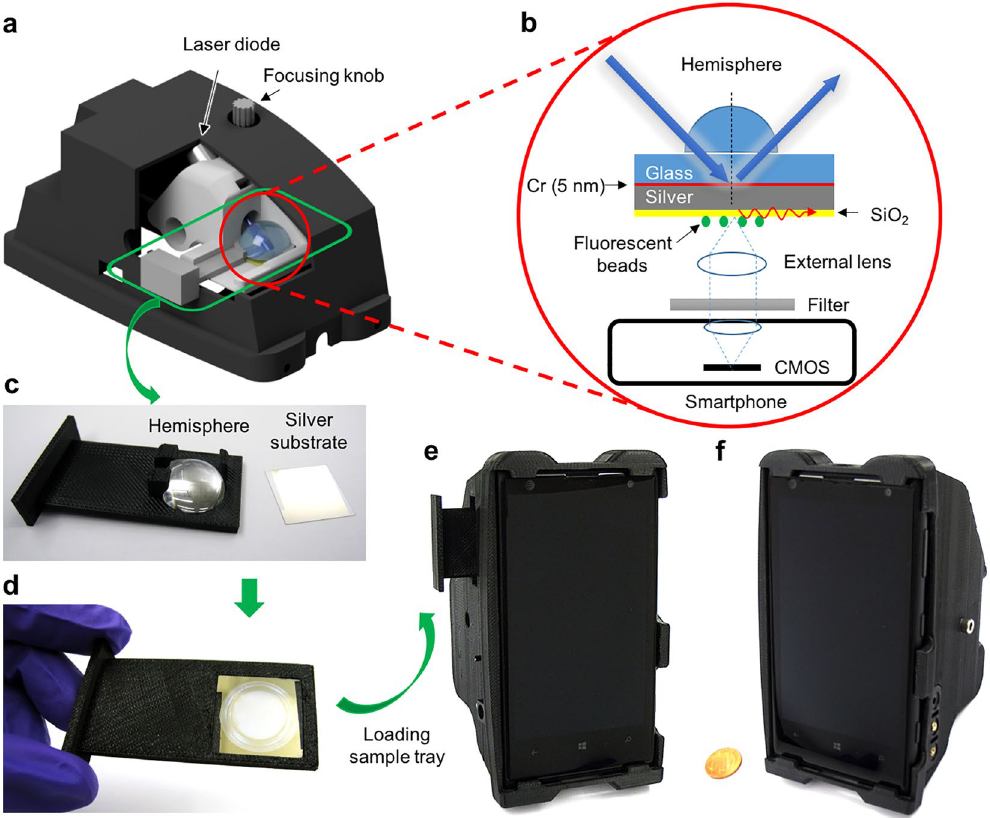
Figure 1. Illustrations and photographs of our mobile phone SEF microscopy device. ( a ) 3D illustration of the smartphone attachment with the cutaway view of the inner sample stage. ( b ) Schematic of the Kretschmann configuration implemented in the smartphone attachment. ( c , d ) Photographs of the hemisphere-embedded sample tray and silver thin film substrate, before ( c ) and after ( d ) loading of the silver-coated substrate onto the hemisphere. ( e , f ) Photographs of the final prototype device from different perspective